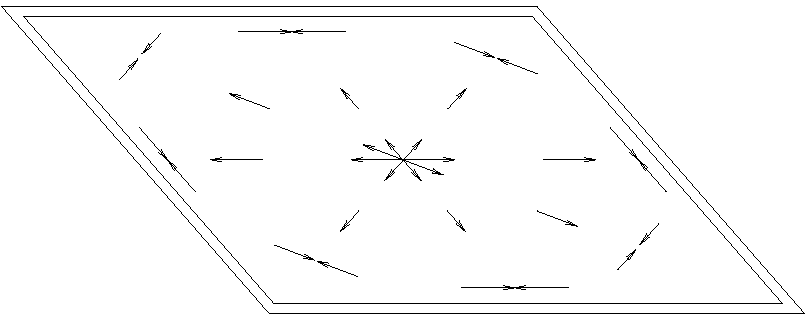
Fig. 2 Membrane tension resisted by membrane compression ring in thin